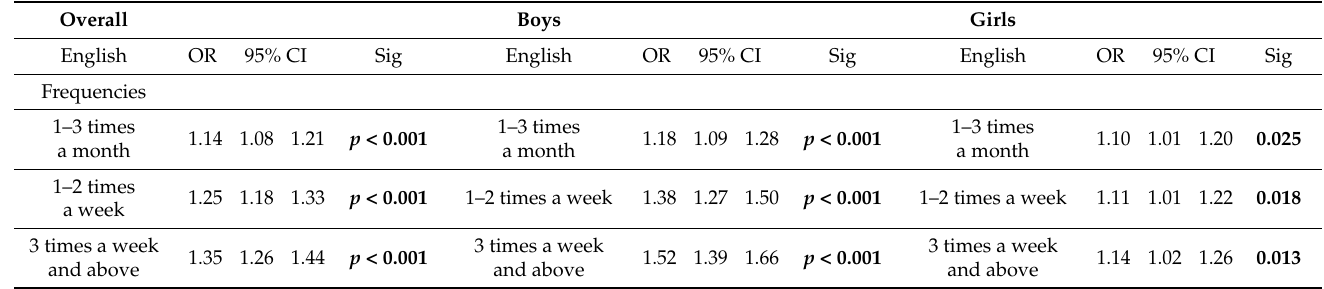
Table 5. Odds ratio and 95% CI for academic performance concerning the sports participation